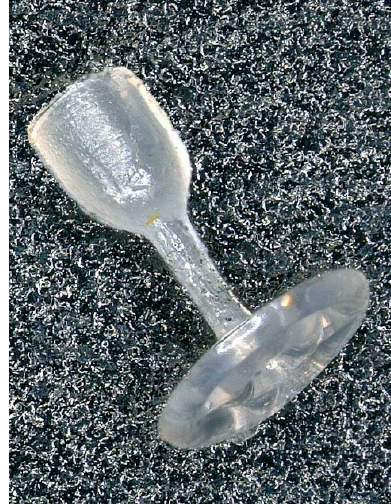
Figure 2. The middle ear implant—otoimplant.